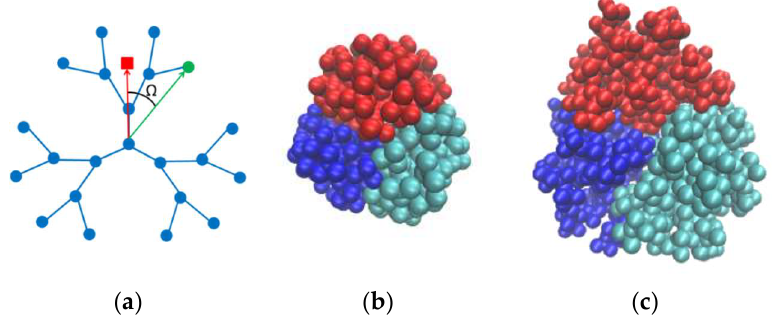
Figure 2. Schematic representation of the angle used to characterize the angular motion of Si branching atoms. The green color indicates the Si atom being studied, and the red square indicates the center of mass of the corresponding dendron ( a ). A balanced molecule of generation-6 (G6) s-dendrimer ( b ) and l-dendrimer ( c ). The different colors in ( b , c ) are painted atoms belonging to different dendrons.